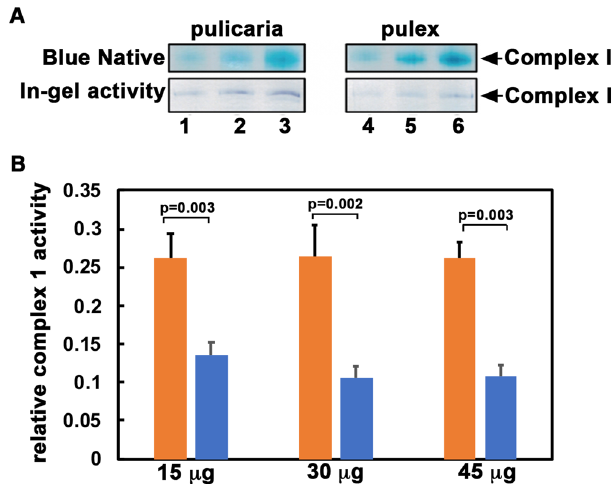
Figure 2. Complex I activity from clones WF6 and XVI-11. ( A ) Blue Native gels and in-gel activity assay for complex I. Extracts made from short-lived WF6 and long-lived XVI-11 clones were run on Blue Native gel for total amount of complex I and a duplicate gel was stained for measuring complex I activity. Lanes 1–3: 15 μg, 30 μg, and 45 μg of total extract prepared from XVI-11 mitochondria and lane 4–6: 15 μg, 30 μg, and 45 μg of total extract prepared from WF6 mitochondria. ( B ) Quantification of relative activity of complex I. The band intensities of total complex I and in-gel activity were measured in 4 separate experiments and the complex I activity relative to total amount of complex I was calculated. Blue bars indicate short-lived WF6 samples and the orange bars indicate long-lived XVI-11 samples. The p-values are as indicated.